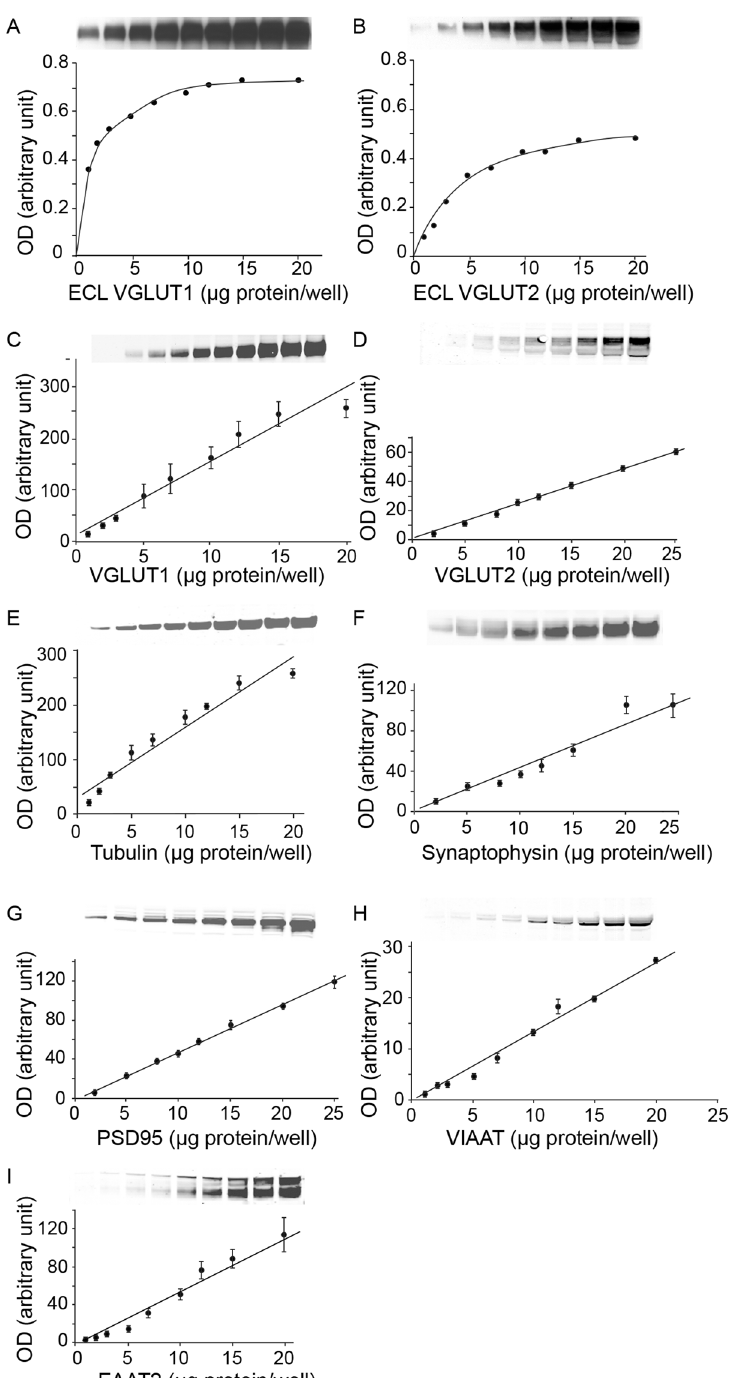
Figure 1. Comparison and linearity of western blot assays coupled to either ECL or infrared detection. Various amounts of BA9 cortical extracts (1–20 µ g protein) were separated on SDS-PAGE gel. VGLUT1 ( A , C ), VGLUT2 ( B , D ), α -tubulin ( E ), synaptophysin ( F ), PSD95 ( G ), VIAAT ( H ) and EAAT2 ( I ) were detected by western blot coupled to ECL ( A , B ) or to infrared detection ( C – I